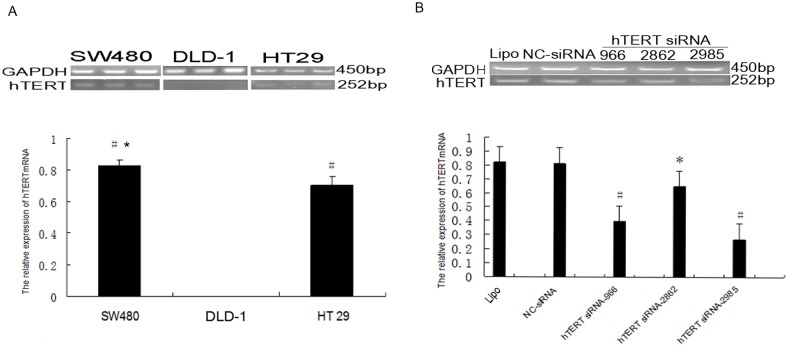
Screening colon cancer cell lines and effective hTERT-siRNA.(A) Endogenous hTERT mRNA expression in SW480, DLD-1 and HT29 cell lines. There were significant differences among SW480, HT29 and DLD-1 cells (#
P<0.01), and between SW480 and HT29 cells (*P<0.05). (B) Potency of hTERT siRNAs in SW480 cells. Levels of hTERT mRNA were significantly lower in the cells transfected with hTERT siRNAs than in cells transfected with negative control (NC) shRNA or Lipofectamine alone (Lipo). *P<0.05, #
P<0.01, compared with the NC-shRNA and Lipo groups. Results are mean ± SD from three independent experiments.